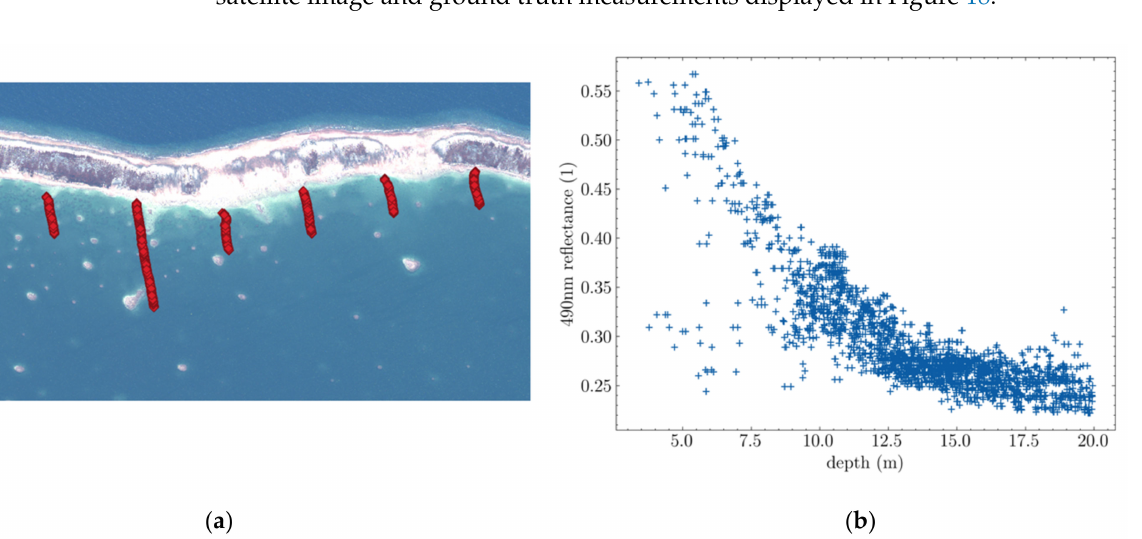
Figure 18. Ground truth provided by multiple sounding lines in Tahanea. ( a ) World View image and supporting ENC cross-sections in red, ( b ) Scatter plot of blue Depth/Reflectance